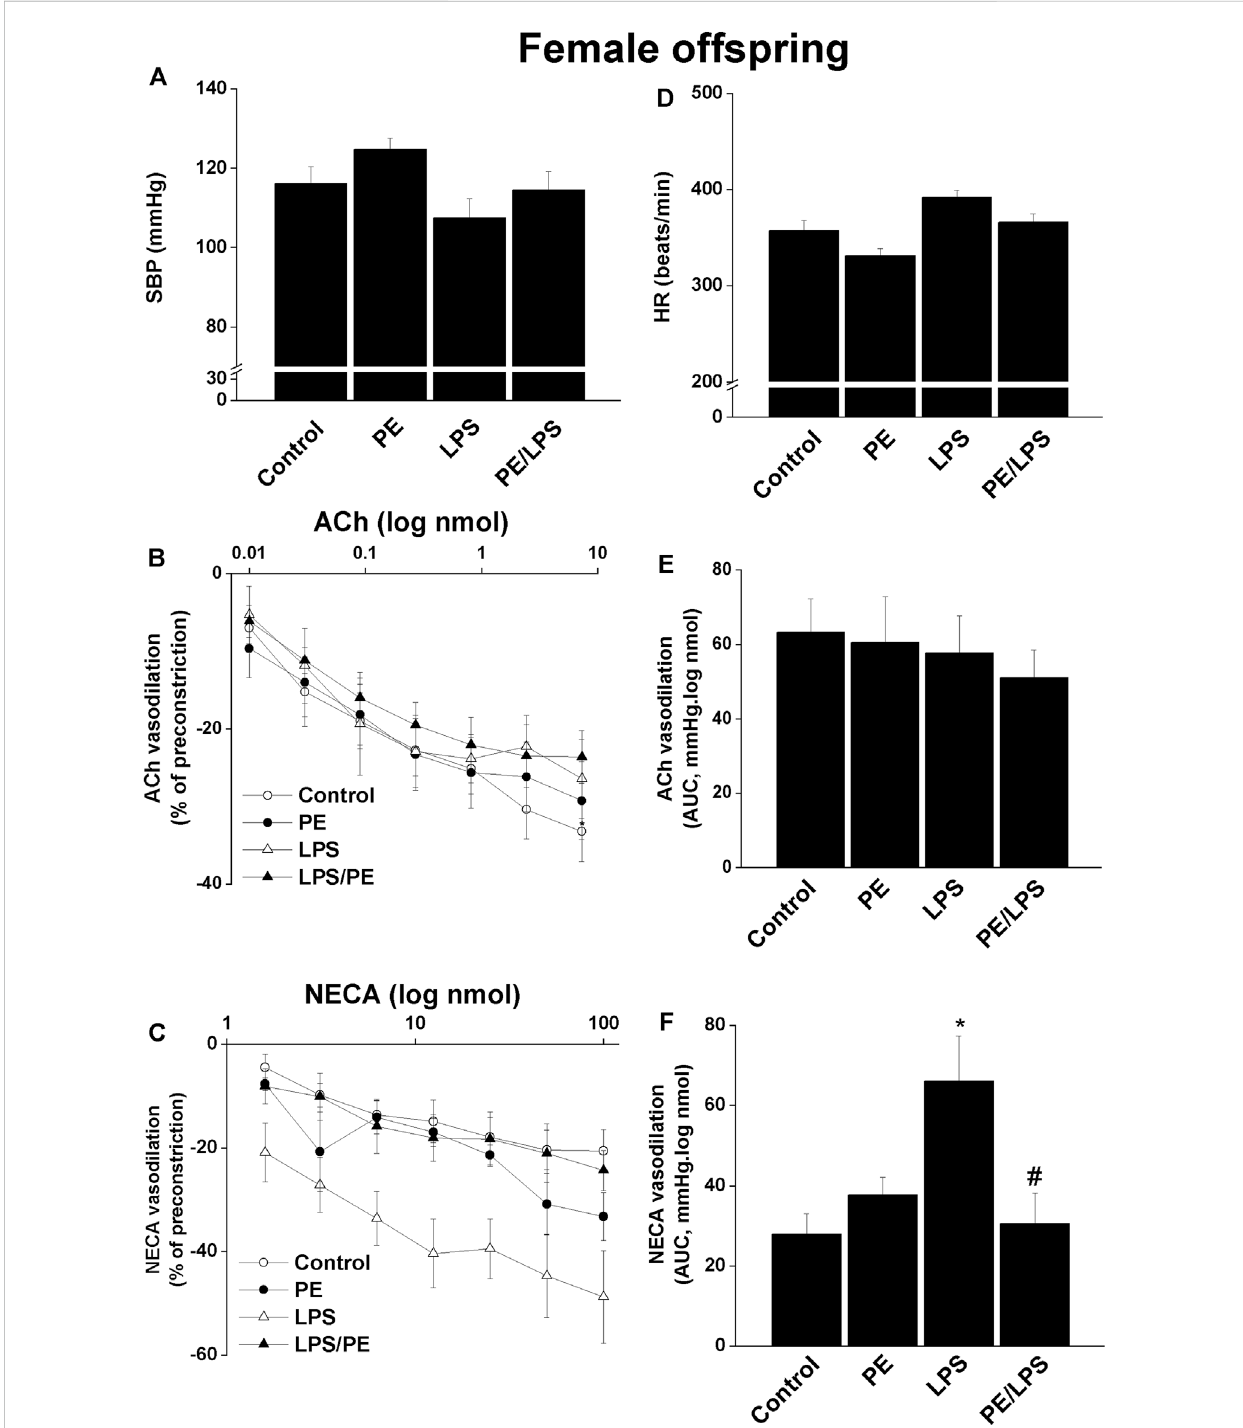
FIGURE 2 Effect of PE on tail cuff systolic blood pressure (SBP, panel A ), heart rate (HR, panel D ), cumulative vasodilatory dose response curves of ACh and NECA(panels B,C )andAUCsofthevasodilatorydoseresponsecurves(panel E,F )inphenylephrinepreconstrictedisolatedperfusedkidneysofendotoxic female offspring, respectively 4 h post intraperitoneal injection of LPS (5 mg/kg) or equal volume of saline. Data are expressed as the mean ± SEM of 7- 8measurements.ANOVAfollowedbytheTukey ’ s posthoc wasutilizedtomeasurestatisticalsigni fi cance.* p < 0.05vs. “ Control ” , # p < 0.05vs. “ LPS ”